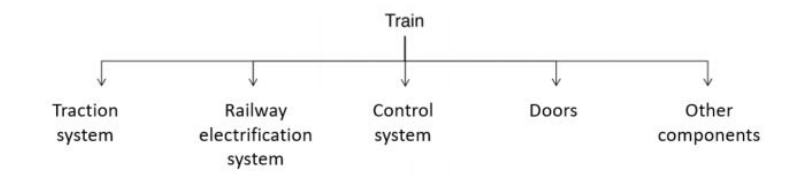
Figure 3. Train system [49].